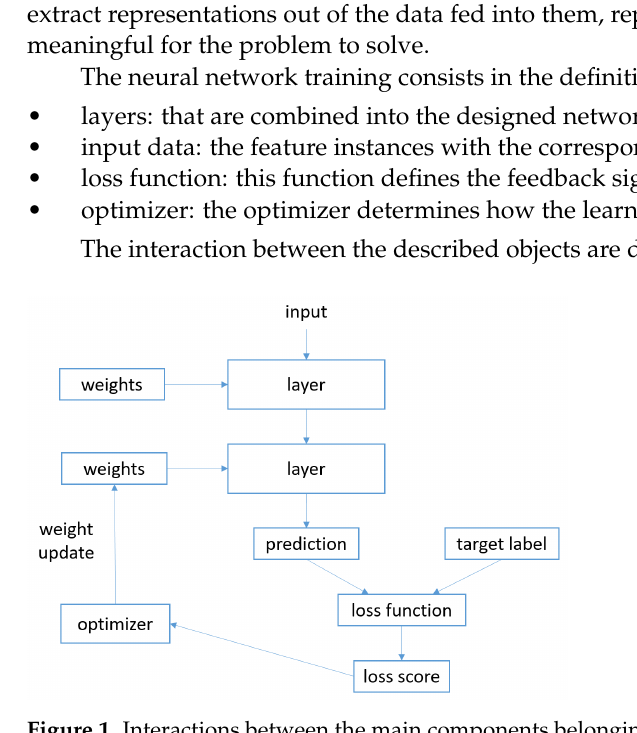
Figure 1. Interactions between the main components belonging to neural